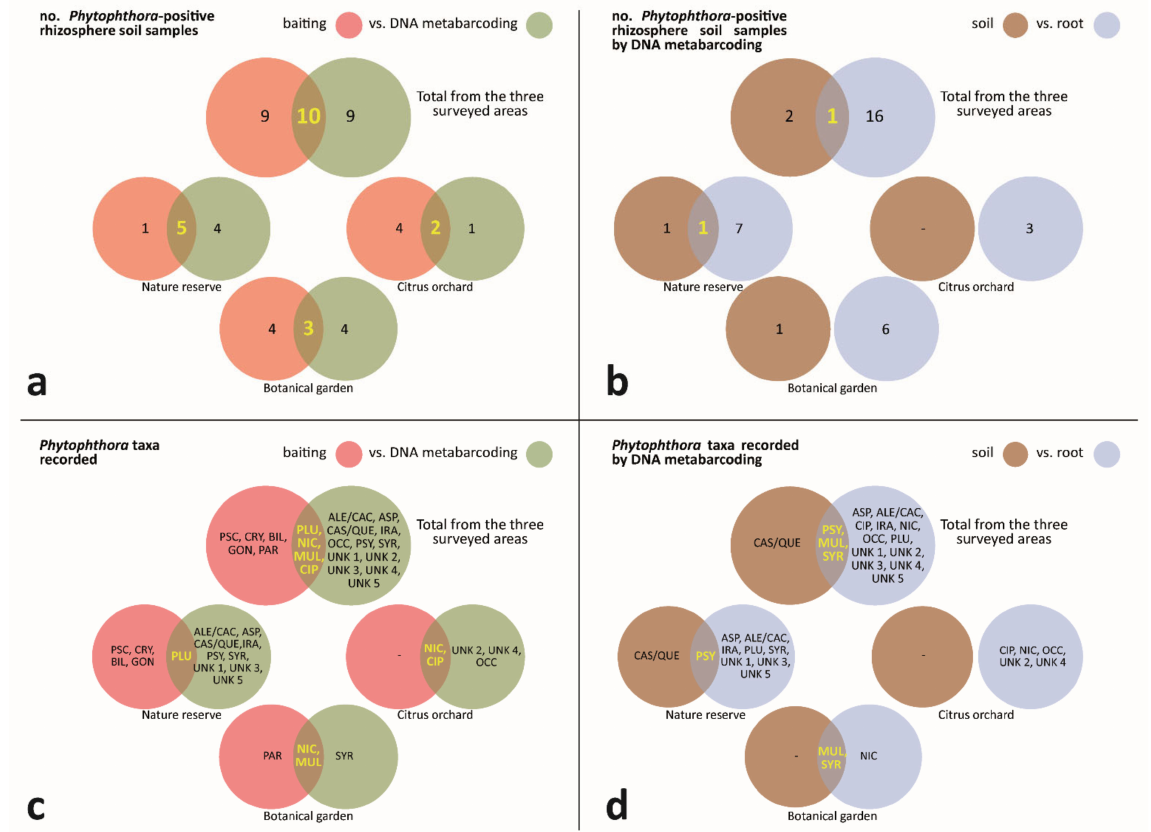
Figure 7. Comparison between: (i) number of Phytophthora -positive rhizosphere soil sam- ples by ( a ) baiting and DNA metabarcoding; ( b ) DNA metabarcoding-processing of roots and soil; (ii) Phytophthora taxa recorded by ( c ) baiting and DNA metabarcoding; ( d ) DNA metabarcoding-processing of roots and soil. ALE/CAC = P. aleatoria / P. cactorum ; ASP = P. as- paragi ; BIL = P. bilorbang ; CAS/QUE = P. castanetorum / P. quercina ; CIP = P. citrophthora ; CRY = P. cryp- togea ; GON = P. gonapodyides ; IRA-like = P. iranica -like; MUL = P. multivora ; NIC = P. nicotianae ; OCC = P. occultans ; PAR = P. parvispora ; PLU = P. plurivora ; PSC = P. pseudocryptogea ; PSY = P. psy- chrophila ; SYR = P. syringae ; UNK 1 = Phytophthora unknown sp. 1; UNK 2 = Phytophthora unknown sp. 2; UNK 3 = Phytophthora unknown sp. 3; UNK 4 = Phytophthora unknown sp. 4; UNK 5 = Phytophthora unknown sp.